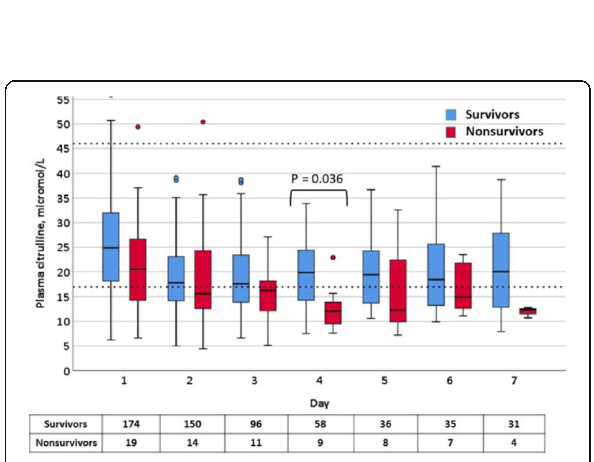
Fig. 2 (abstract 000298). Plasma citrulline dynamics in 28 day survivors vs nonsurvivors